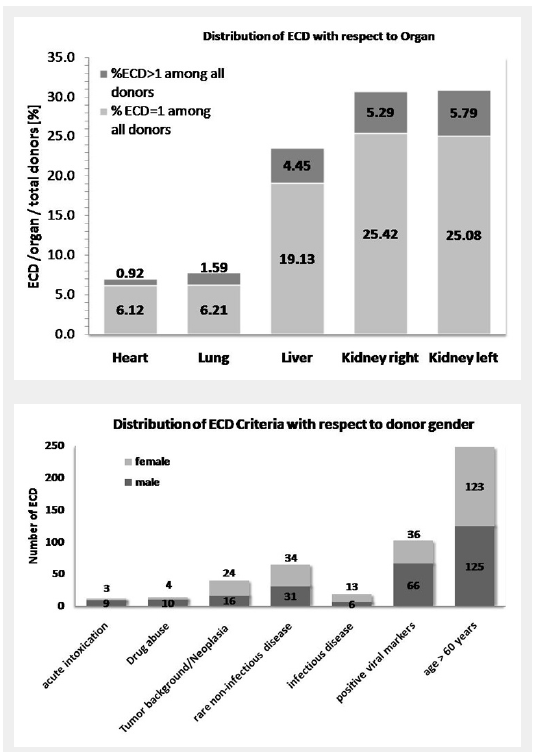
Relative distribution of organs from ECD with 1 and >1 fulfilled criterion in all donated hearts, lungs, livers and kidneys. Percent of ECD among all transplanted organs is shown with respect to the proportion of donors fulfilling 1 or >1 criteria (seven criteria: six DOPKI and advanced